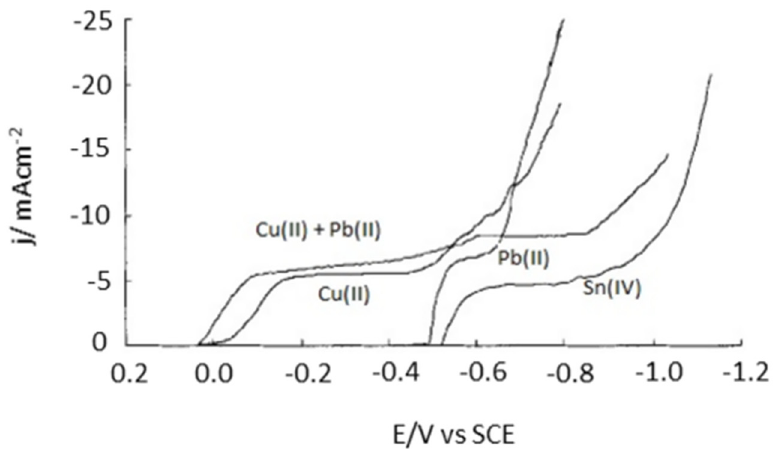
Figure 10. The LSV curves for 0.01 M Cu(NO 3 ) 2 + 0.5 M NaNO 3 , 0.01 M Pb(NO 3 ) 2 + 0.5 M NaNO 3 , 0.01 M Cu(NO 3 ) 2 + 0.01 M Pb(NO 3 ) 2 + 0.5 M NaNO 3 , 0.01 M H 2 SnCl 6 + 1.5 M HCl at a scan rate of 5 mV s − 1 . Reproduced with permission. [88] Copyright 2002, Wiley.